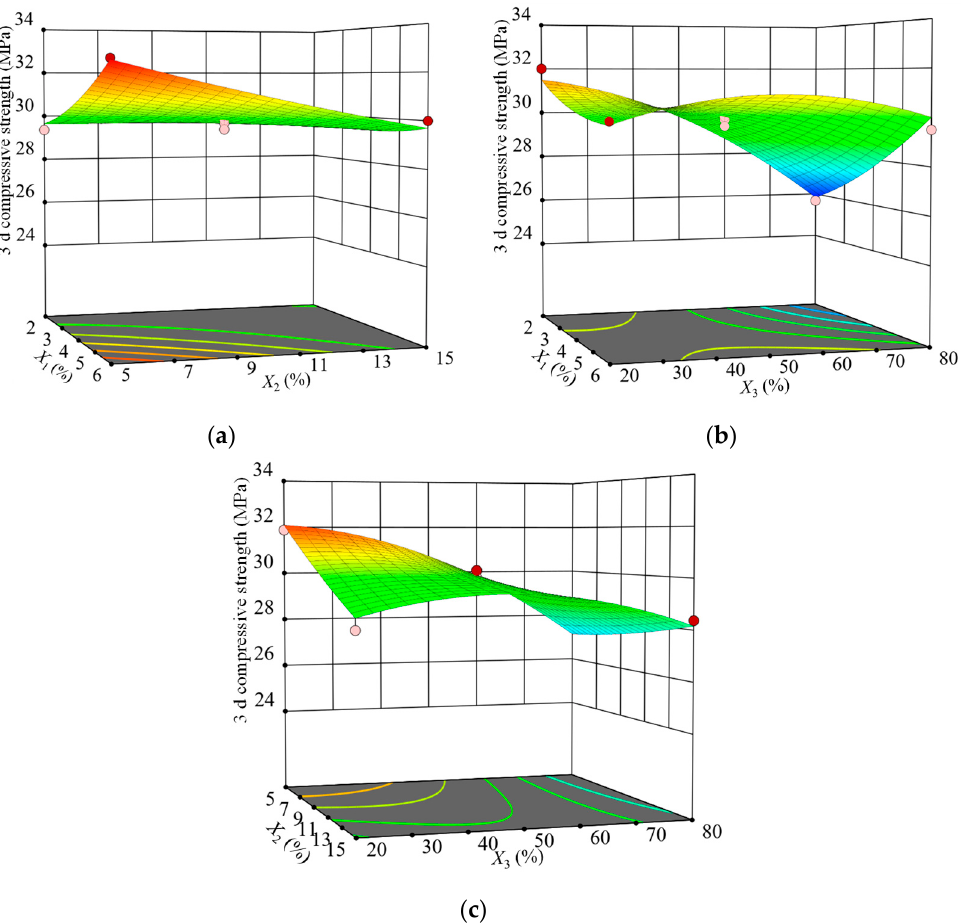
Figure 3. Influences of the interactions of various factors on the 3 d compressive strength: ( a ) X 1 and X 2 , ( b ) X 1 and X 3 , and ( c ) X 2 and X 3.